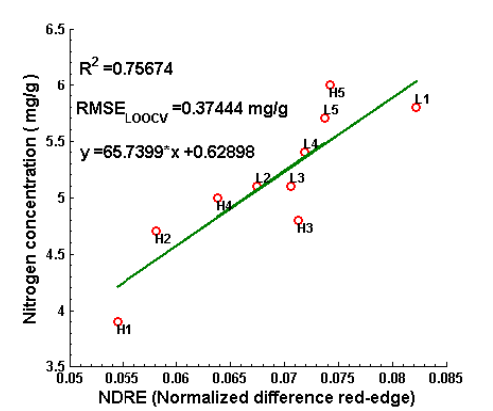
Figure 4 Regression plot between the laboratory analysed nitrogen concentration (mg/g) and the Normalized Differential Red-edge